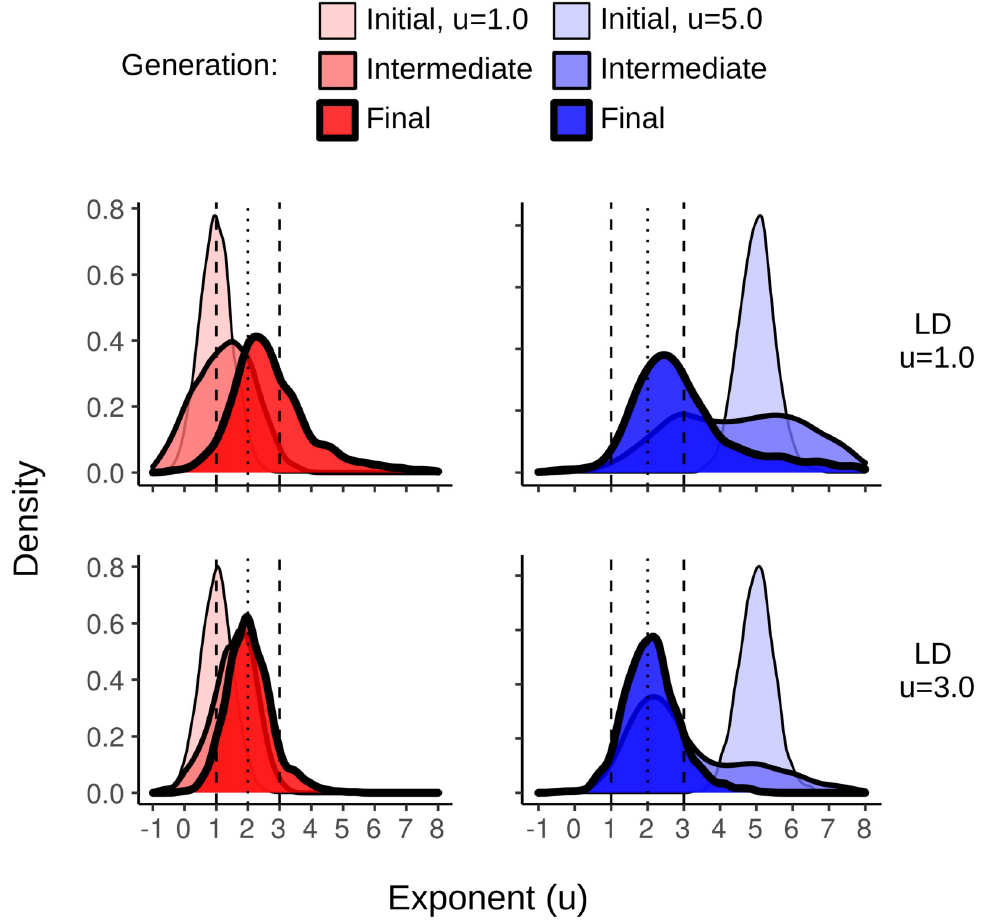
Fig 13. Increasing the length of a lifespan selects for Le´vy-like exponents. The density curves of foraging exponents for the initial, intermediate, and final generations of evolutionary simulations with lifespans of λ = 2.5M and a searching cost χ = 1/8000. The first generations were composed of 1500 DOs with mean foraging exponents u = 1.0 or u = 5.0, and σ sv = 0.5. The top row is the results from a LD dimension u = 1.0 resource distribution, the bottom LD dimension u = 3.0.